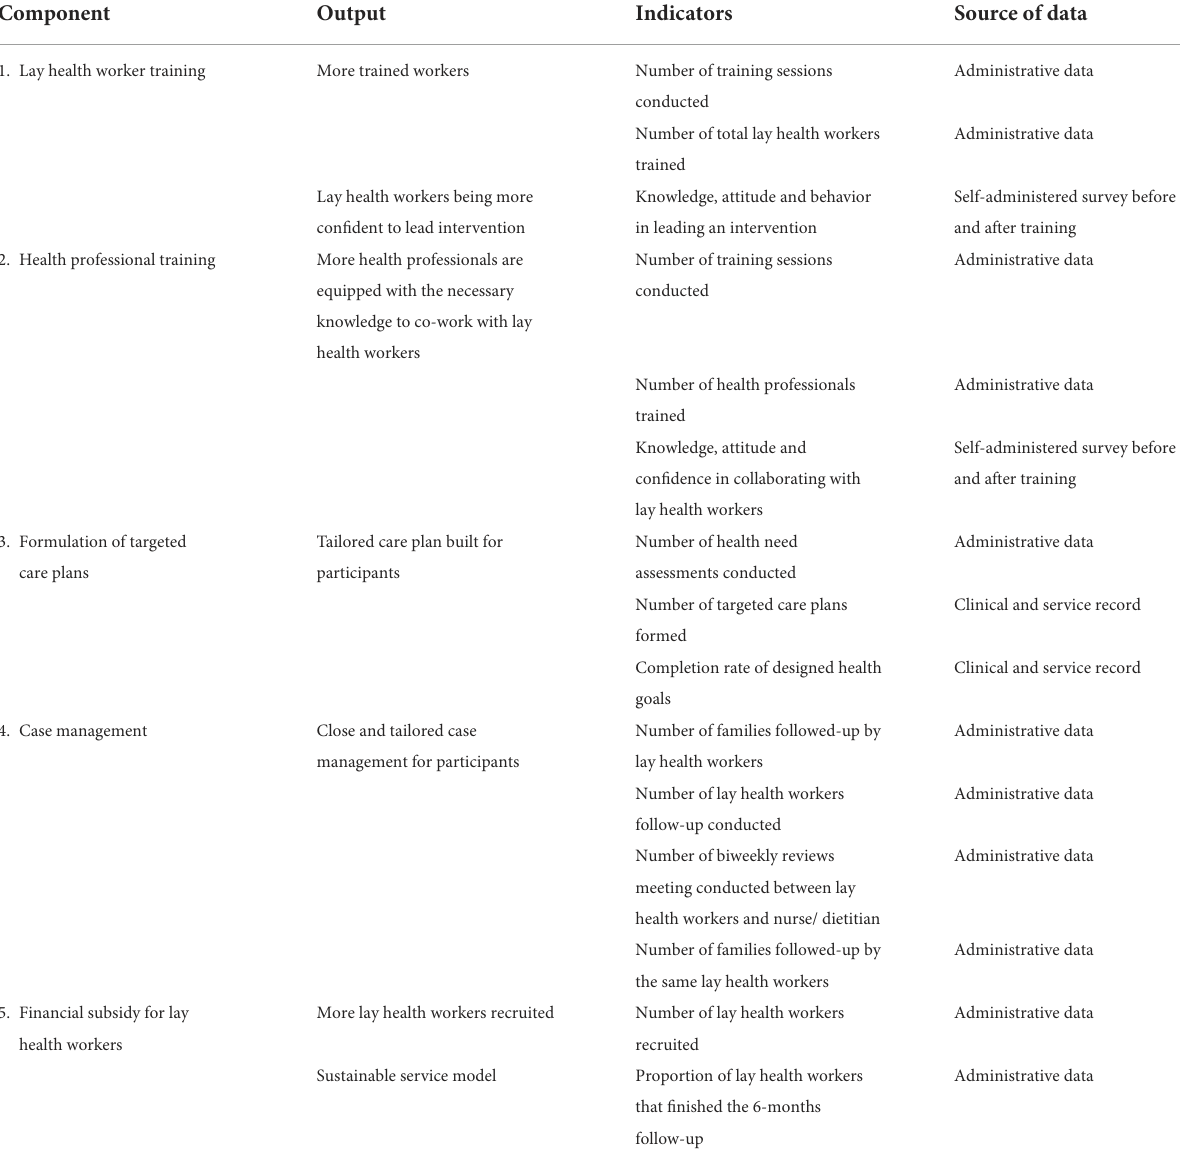
TABLE 2 Outline of the process evaluation: output